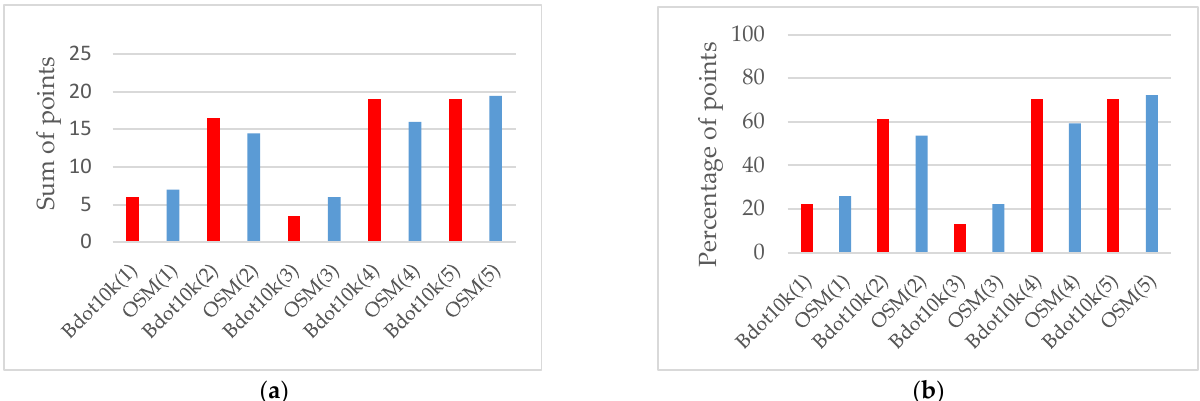
Figure 4. Usefulness of BDOT10k and OSM data — the first level of map detail: ( a ) sum of points; ( b ) percentage of points.